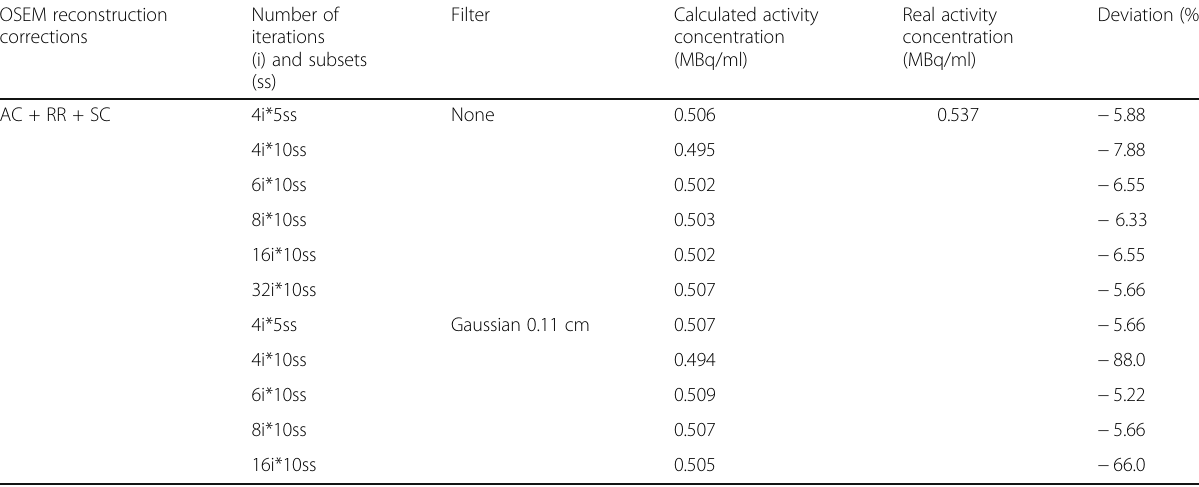
Table 2 Deviation between the activity concentration calculated from SPECT/CT images and the real activity concentration inside the bottle to simulate a kidney OSEM reconstruction corrections